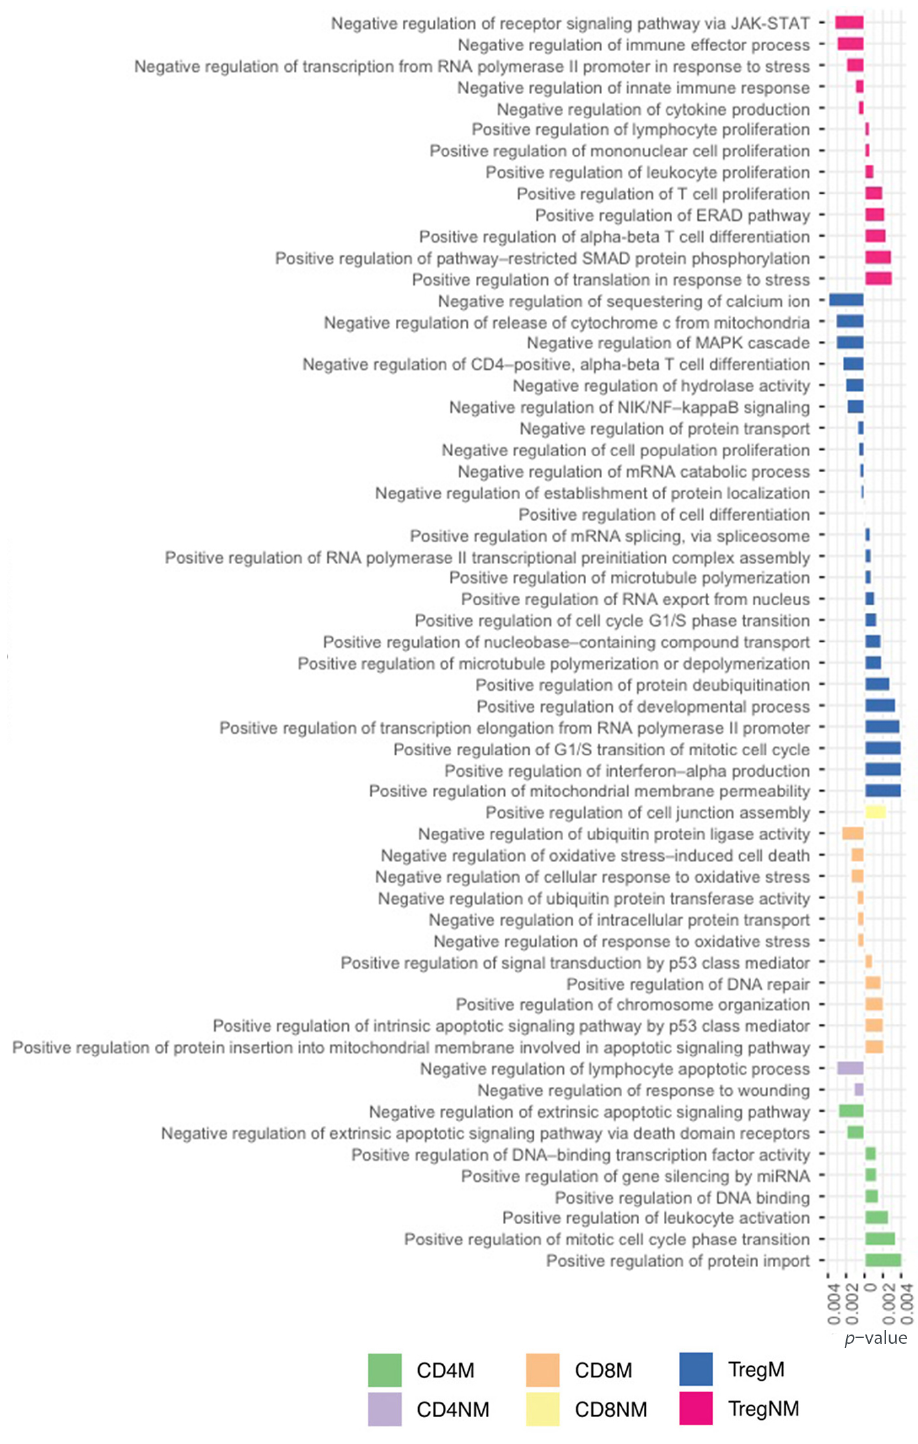
Figure 5. Exclusive GO terms for biological processes associated with positive and negative regula- tions to each T-cell